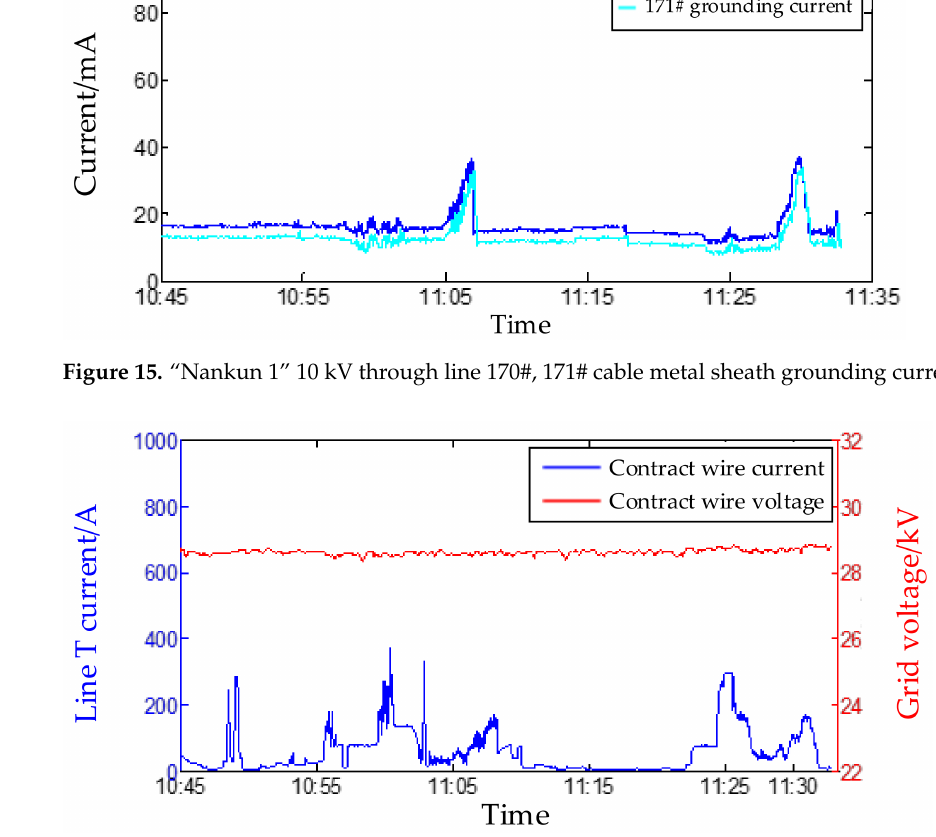
Figure 16. “Nankun 1” traction substation in the test time of each electrical